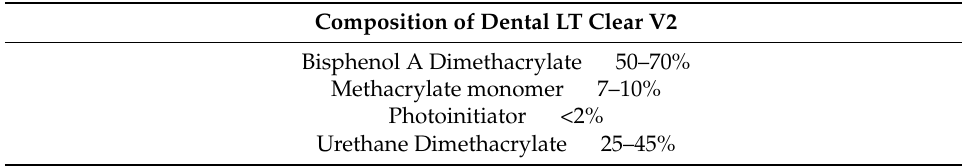
Table 1. Composition of the investigated material.